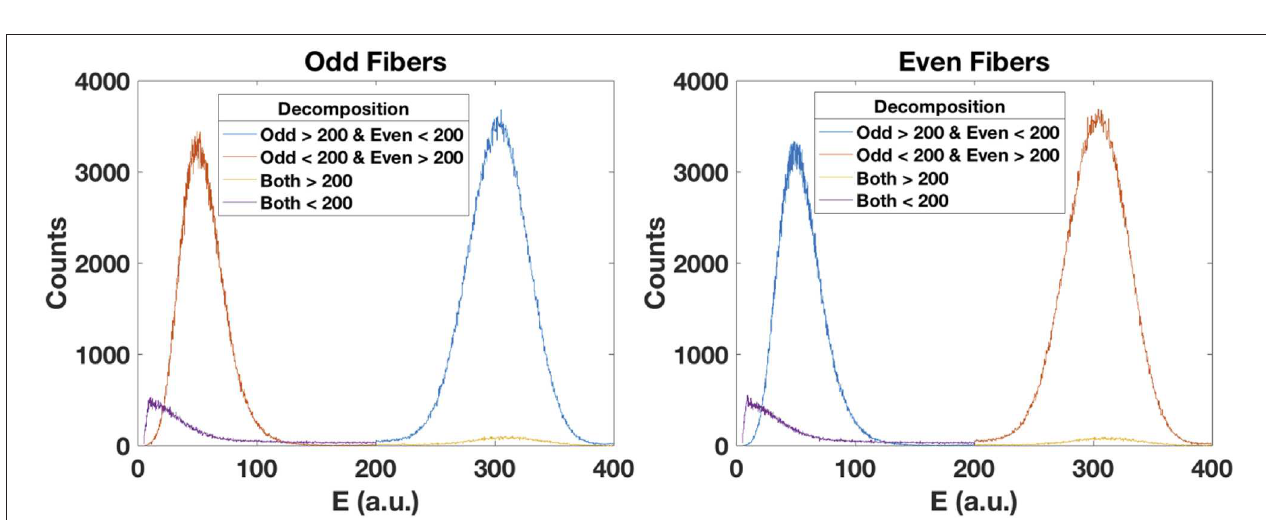
FIGURE 11 | The energy deposited by carbon ions in the scintillating fibers produces cross-talk in the corresponding neighboring fiber. For the odd fibers (left) , we can decompose the events by setting a threshold and performing logic operations. The blue curve corresponds to the relevant events. Conversely, for the even fibers (right) , the relevant events are represented in the red